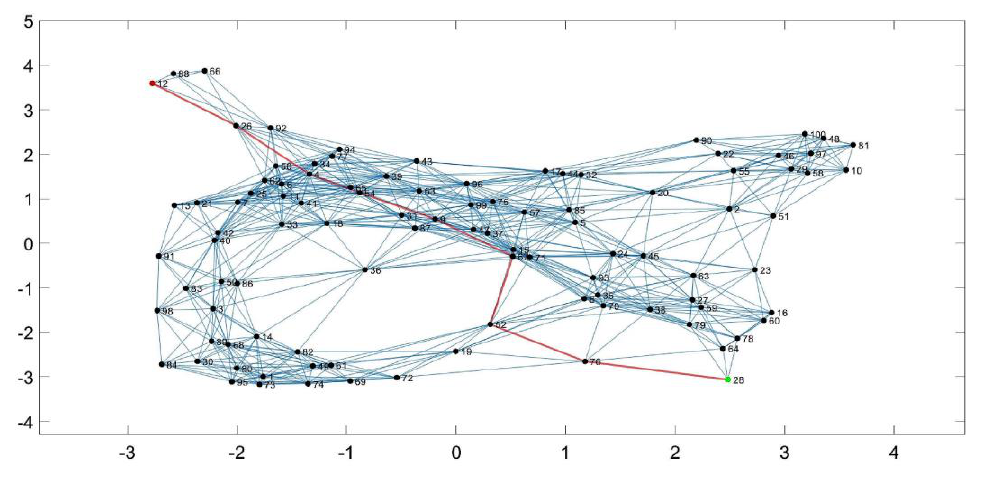
Figure 1. Simulated network.